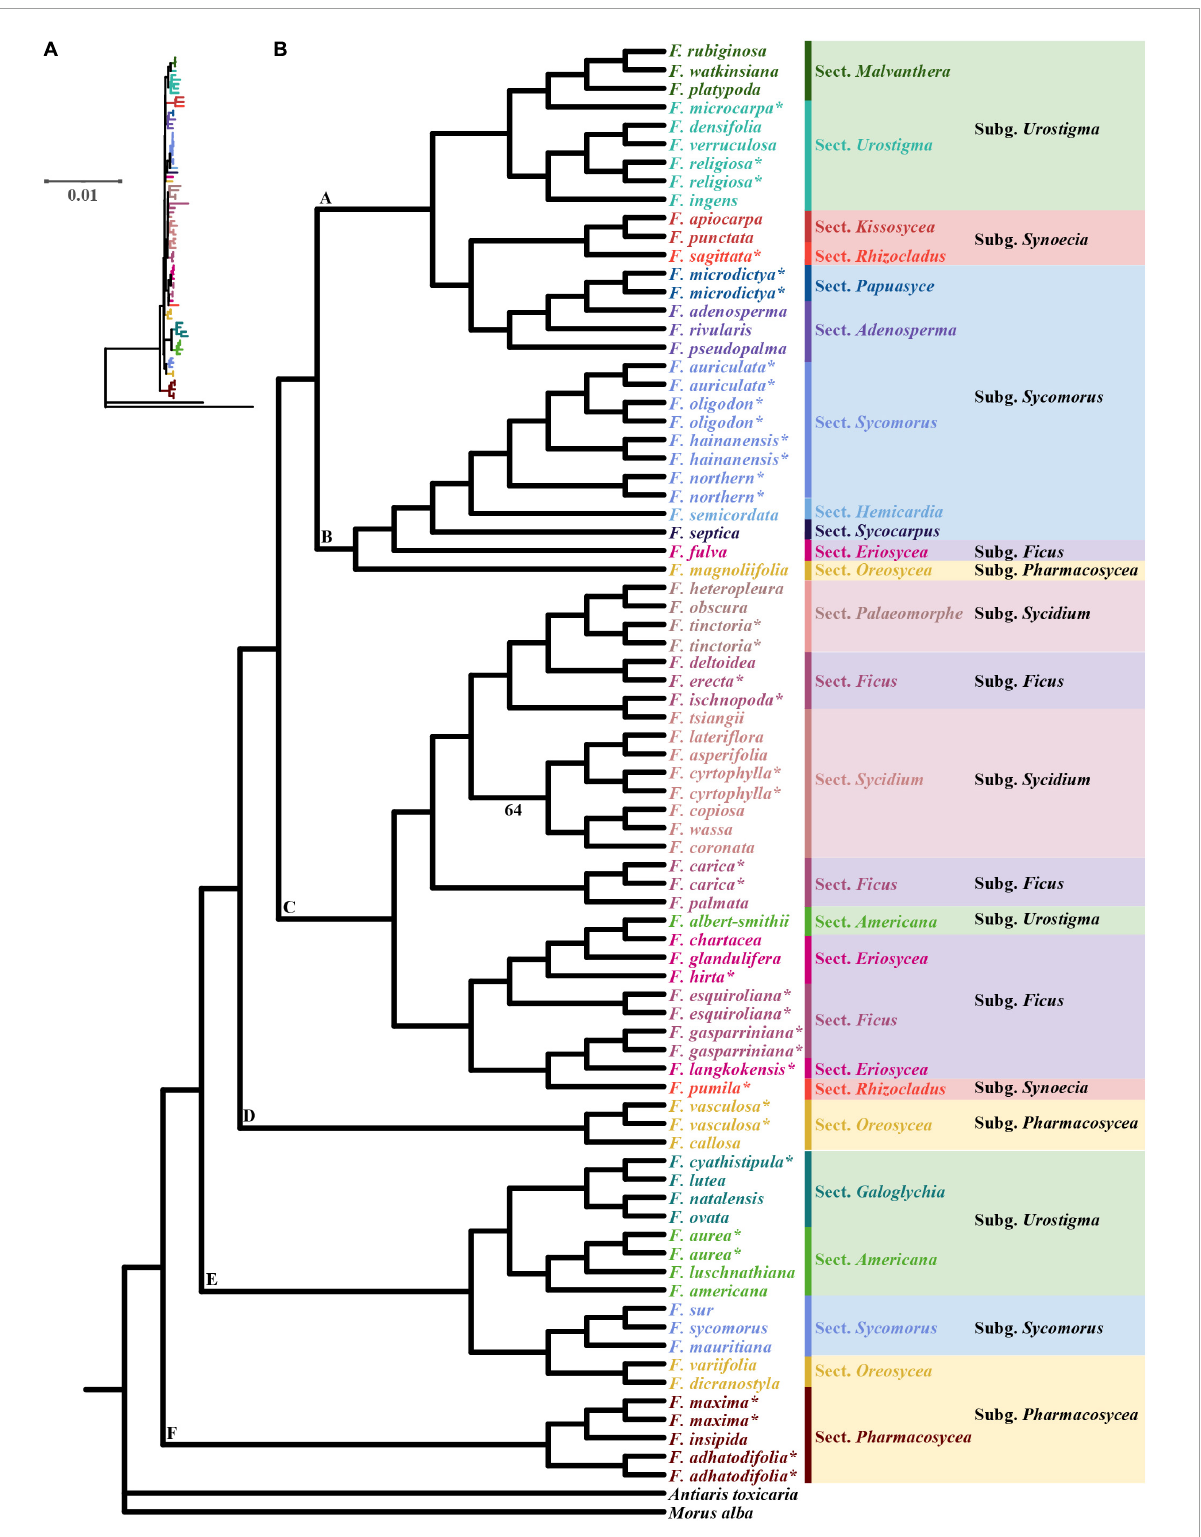
FIGURE3 Maximum-likelihood (ML) phylogram (A) and cladogram (B) of 63 Ficus species inferred from whole chloroplast genome sequences. ∗ Indicates the chloroplast was obtained in this study, the other 40 Ficus species were downloaded from Bruun-Lund et al. (2017). Only branches with weak support (bootstrap < 70%) are